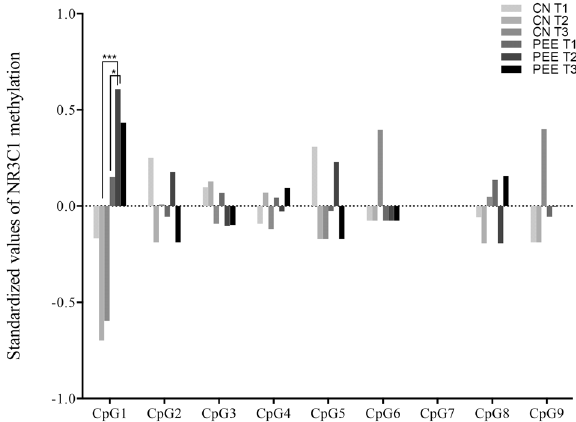
Fig. 3 Standardized values of NR3C1 1 F promoter methylation in nine CpG sites of different subgroups. Only CpG1 site showed signi fi cantly change of methylation among the subgroup. The second trimester had a markedly higher methylation than the fi rst trimester in PEE group. A signi fi cant higher methylated status also was detected in the second trimester of PEE group compared with the same subgroups of CN group. CN control group, PEE prenatal earthquake exposure group, T1 fi rst trimester, T2 second trimester, T3 third trimester. * p < 0.05, *** p <